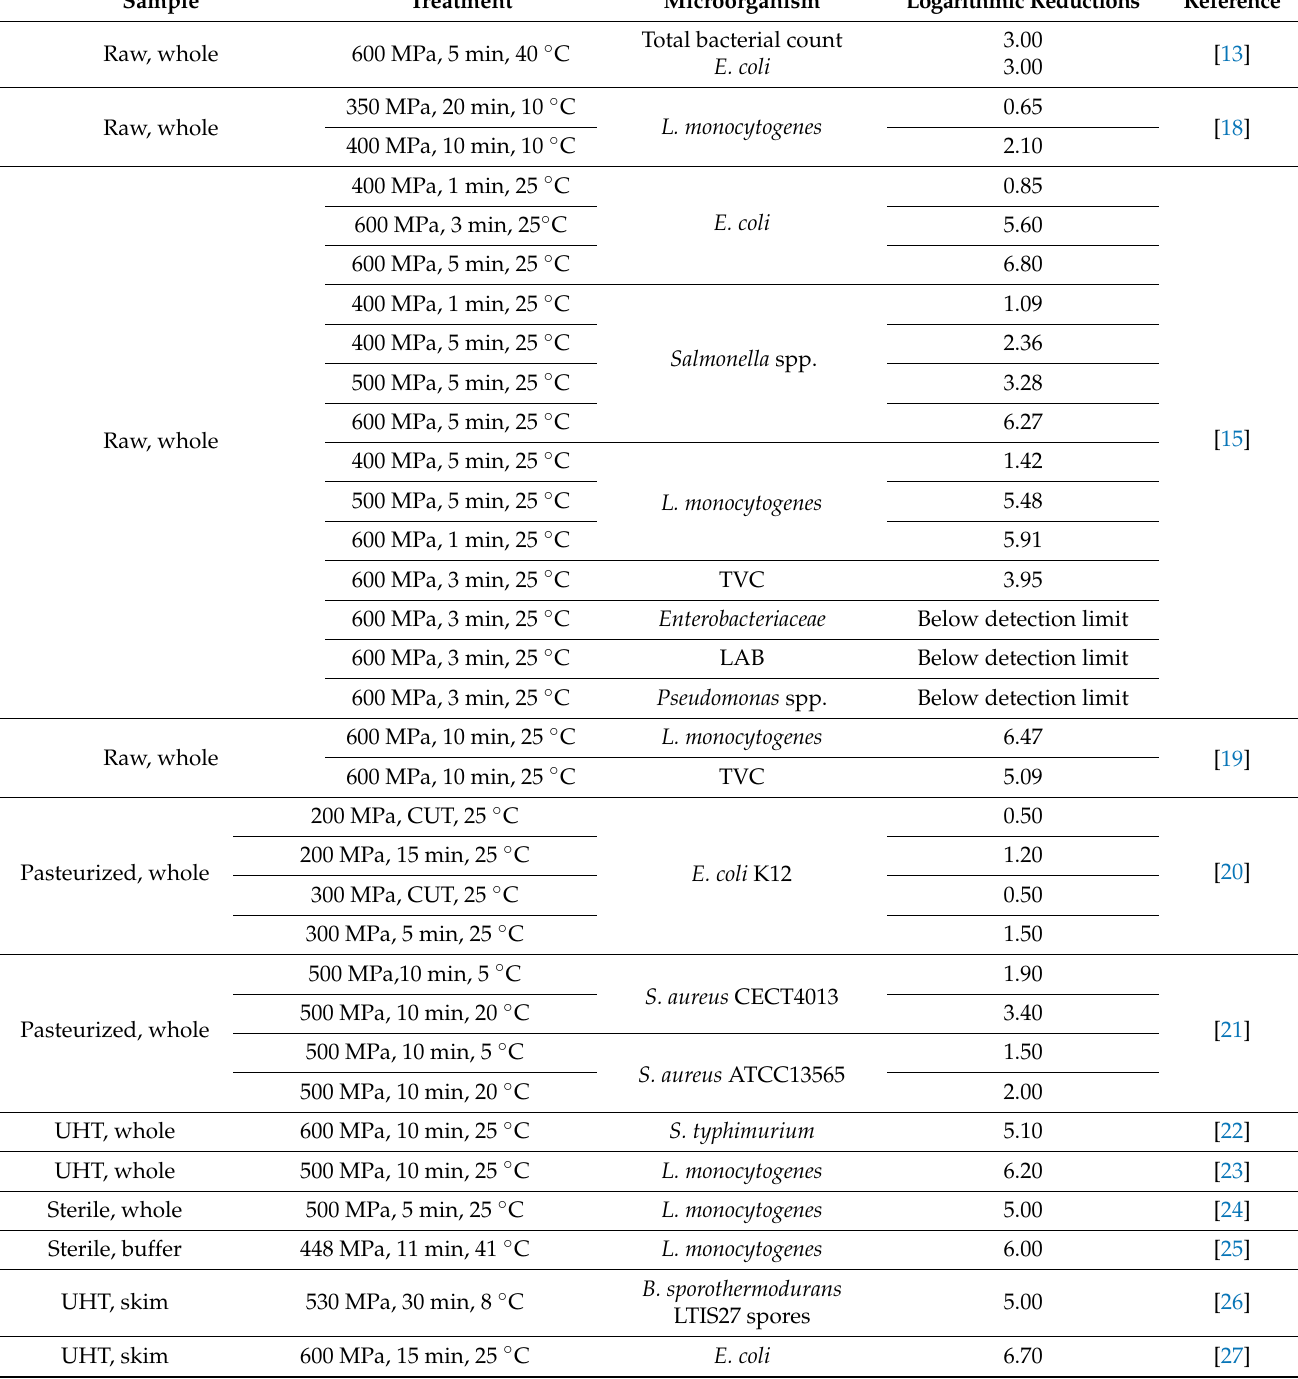
Table 1. Effects of HPP on the inactivation of microorganisms of